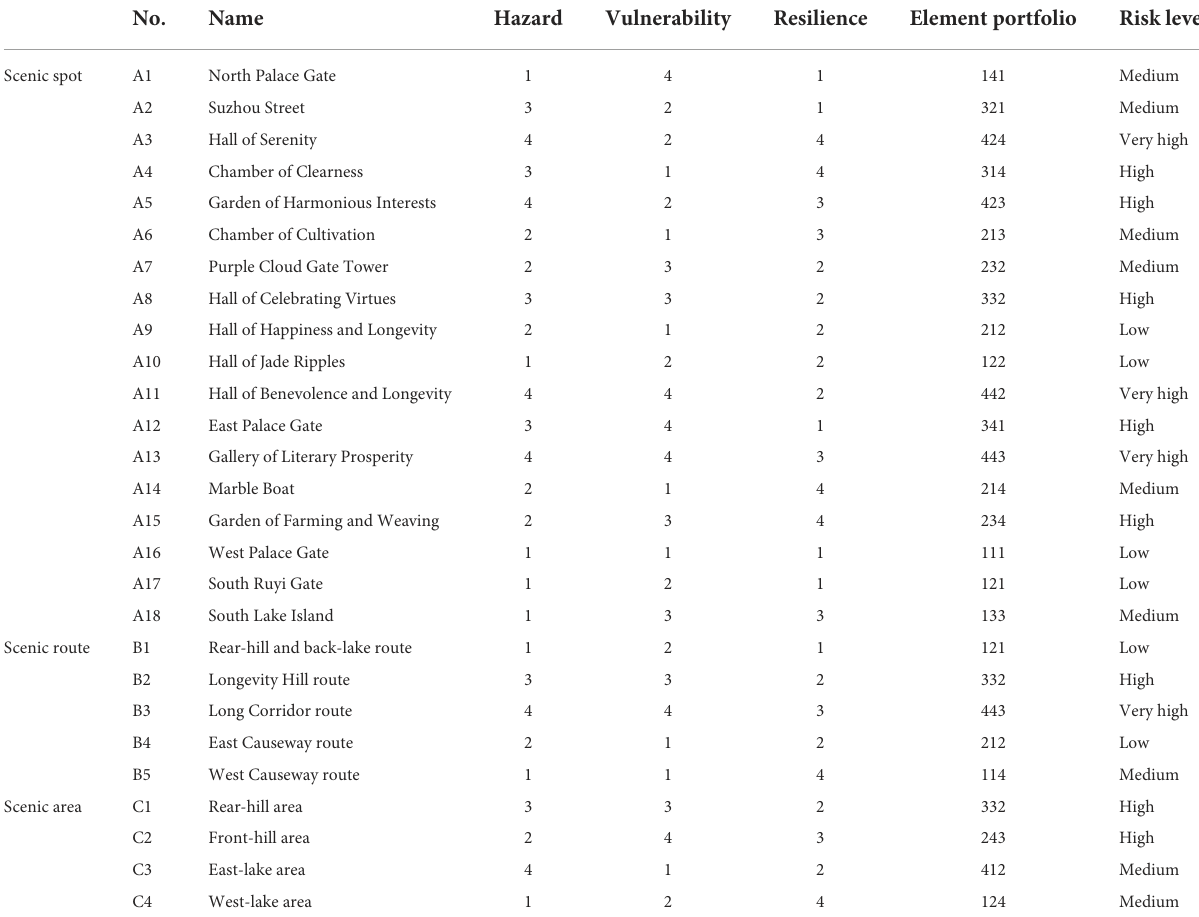
TABLE 5 Assessment results of pollen-allergy risk for tourists in the Summer Palace. No. Name Hazard Vulnerability Resilience Element portfolio Risk